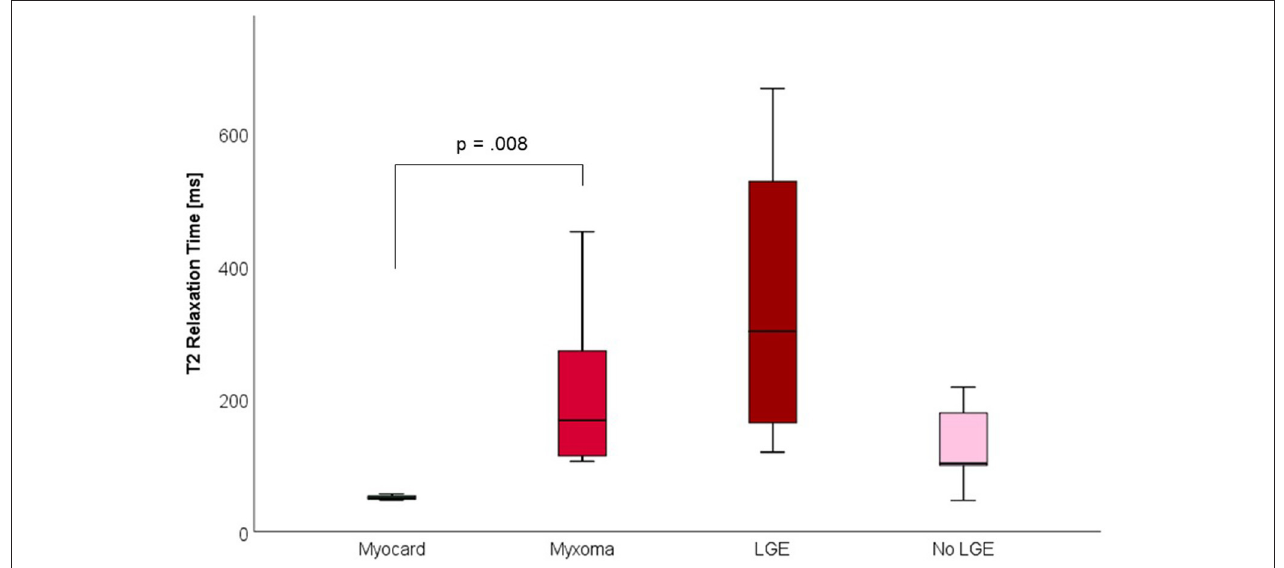
FIGURE 6 | T2 Relaxation Times (in milliseconds) of myocardium and myxoma. Where areas with and without LGE were discernible, respective measurements were taken.